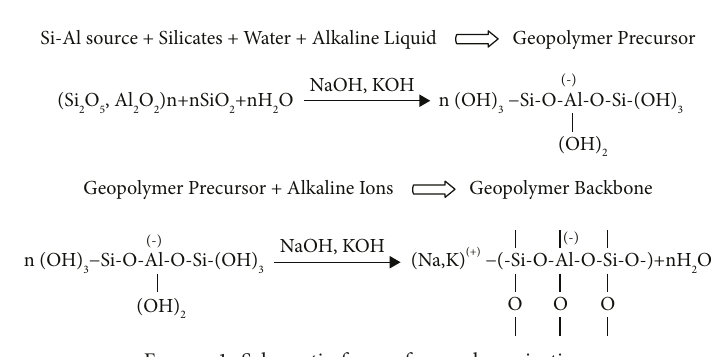
Figure 1: Schematic form of